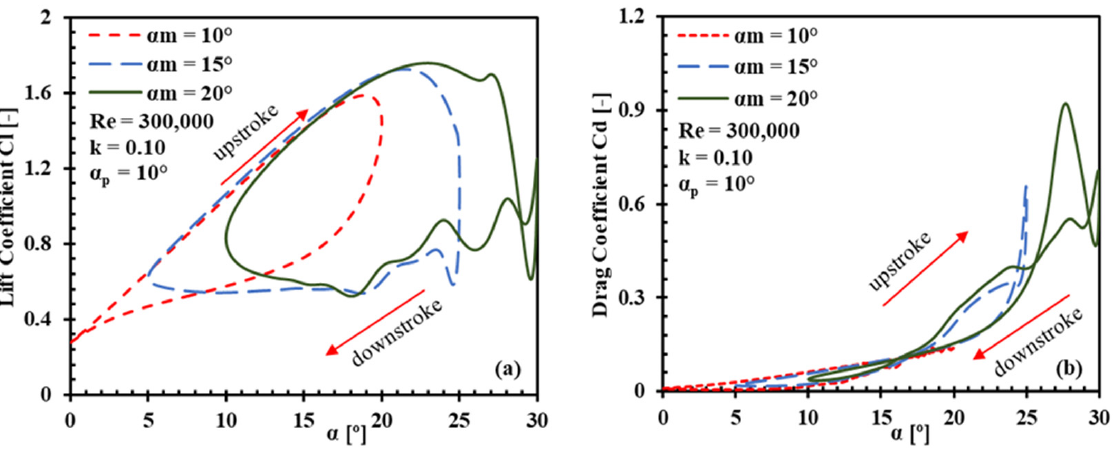
Figure 12. Aerodynamic coefficients of ( a ) lift and ( b ) drag for mean angles of 10°, 15°, and 20° during upstroke and downstroke motion.